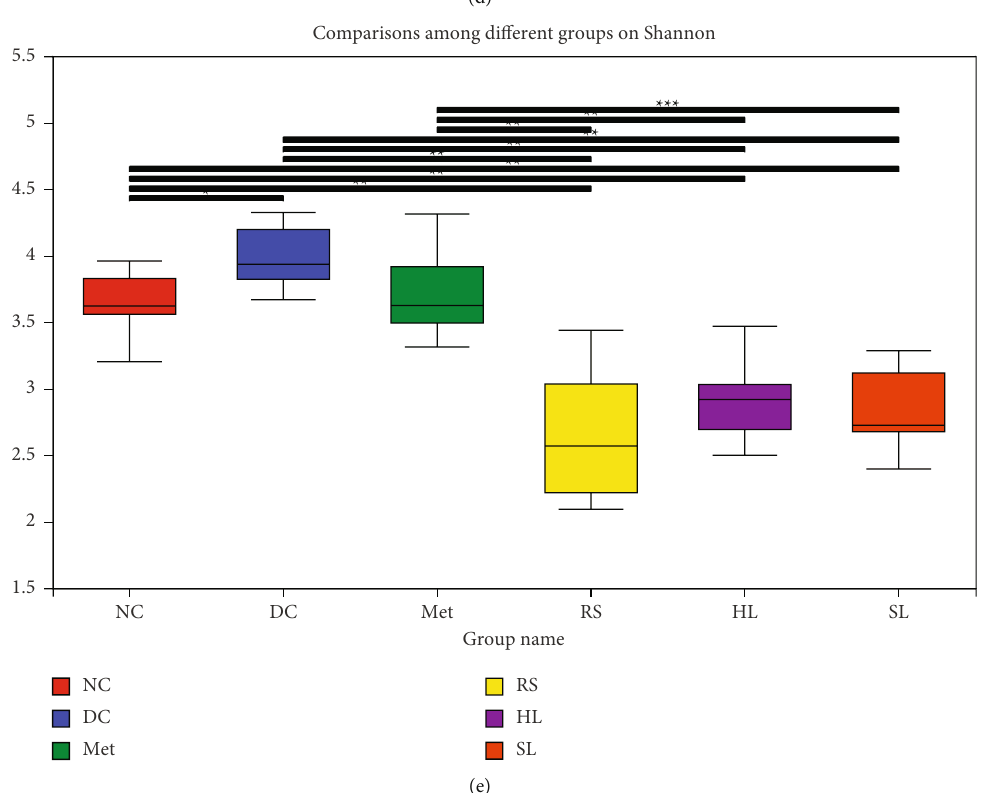
Figure 2: Alpha diversity analysis of bacterial relative abundances. (a) Sobs, (b) Shannon, and (c) coverage diversity curves of gut microbiota community, which re fl ect the richness, diversity, and coverage of the community, respectively. Comparisons among di ff erent groups on (d) Sobs and (e) Shannon of gut microbiota were signi fi cant. ∗ P < 0 : 05 ; ∗∗ P < 0 : 01